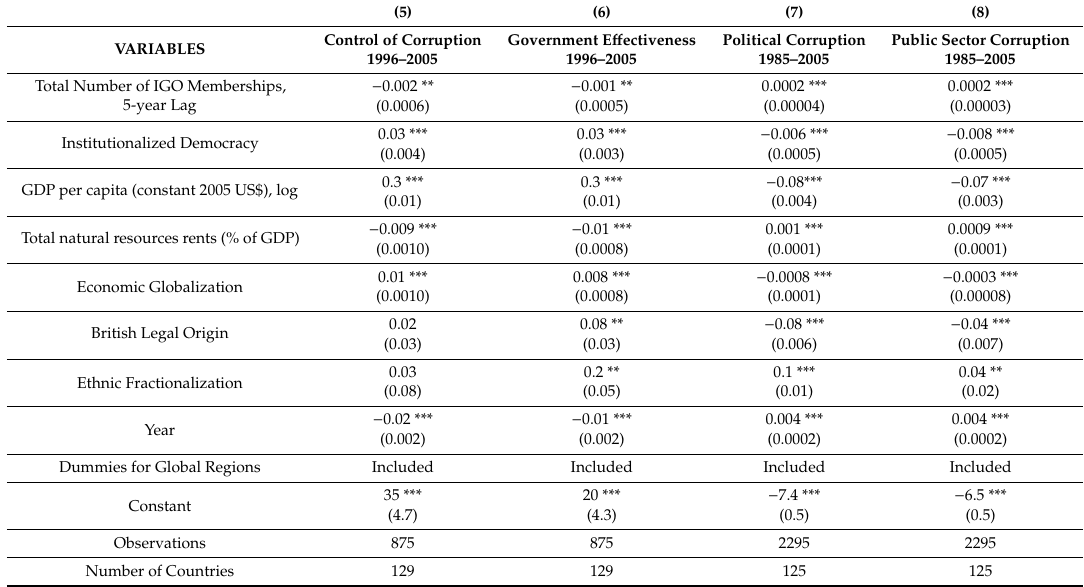
Figure 2. Fitted values of the quality of government index and income levels. Note: The dependent variable, The quality of government index, ranges from ZERO to ONE. Higher scores indicate better government performance. In our sample, the mean of the quality of government index is 0.56; SD = 0.23. The mean number of IGOs in which a country participated during the time period of our analysis is 49 (SD = 23.6). Table 2. Four alternative dependent variables: Cross-section time-series models, GLS